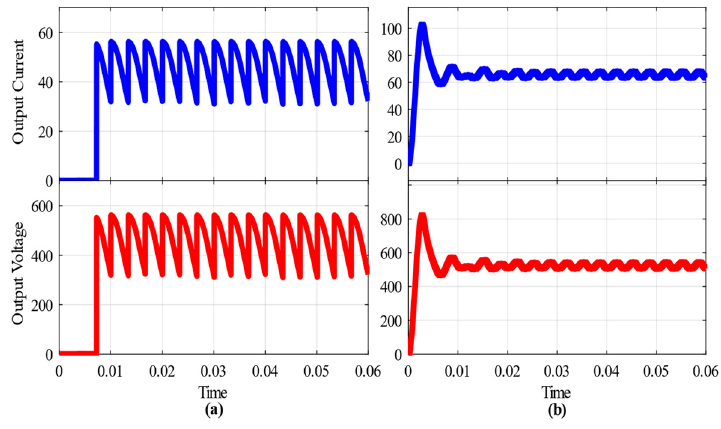
Figure 35. Output current-voltage waveforms of AC–DC rectifier: ( a ) bridgeless boost rectifier; and ( b ) Vienna rectifier.